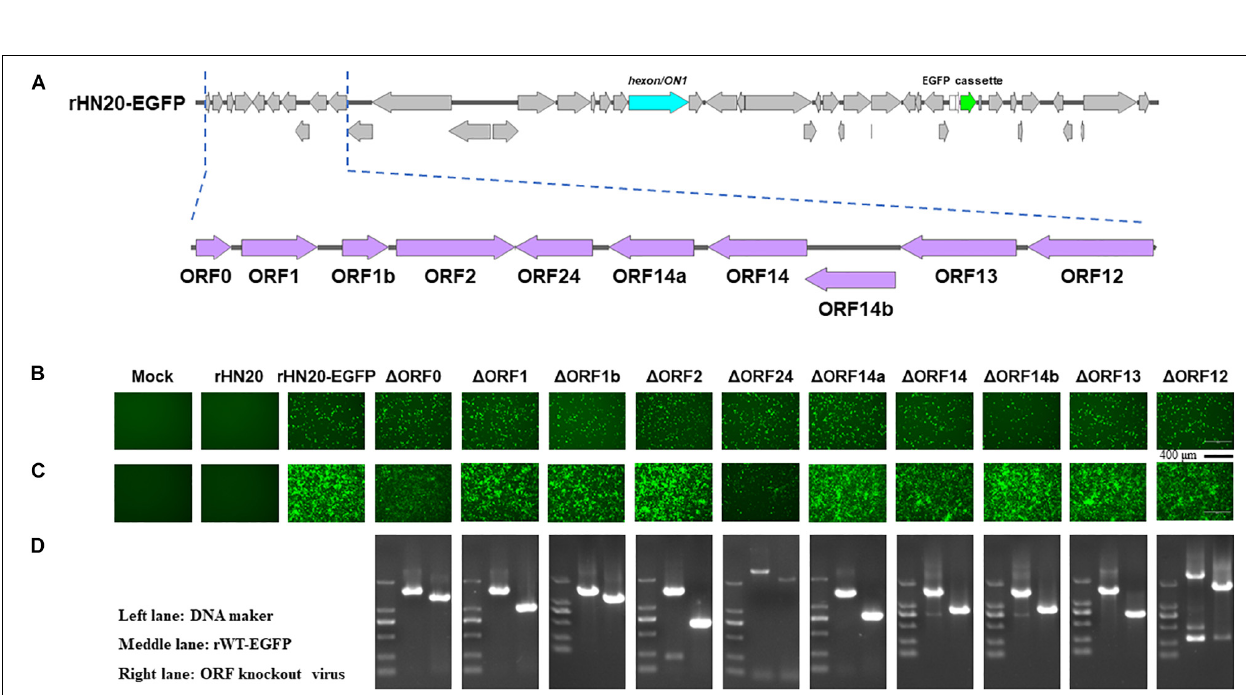
FIGURE 1 | Construction of the rHN20-EGFP recombinant virus. (A) Diagram of rHN20-EGFP. (B) Green fluorescence in LMH cells infected with rHN20 and rHN20-EGFP. (C) PCR identification of rHN20-EGFP. (D) Replication kinetics of rHN20 and rHN20-EGFP.